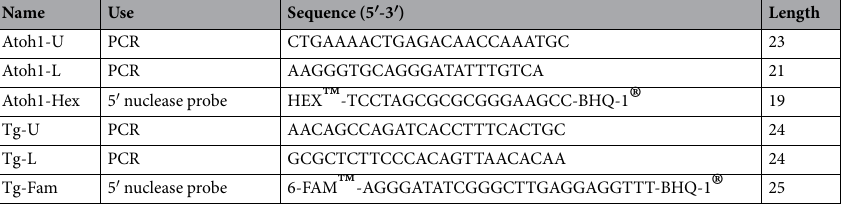
Table 6. Tg-(GFAP- Mir183,Mir96,Mir182 ) genotyping primers and